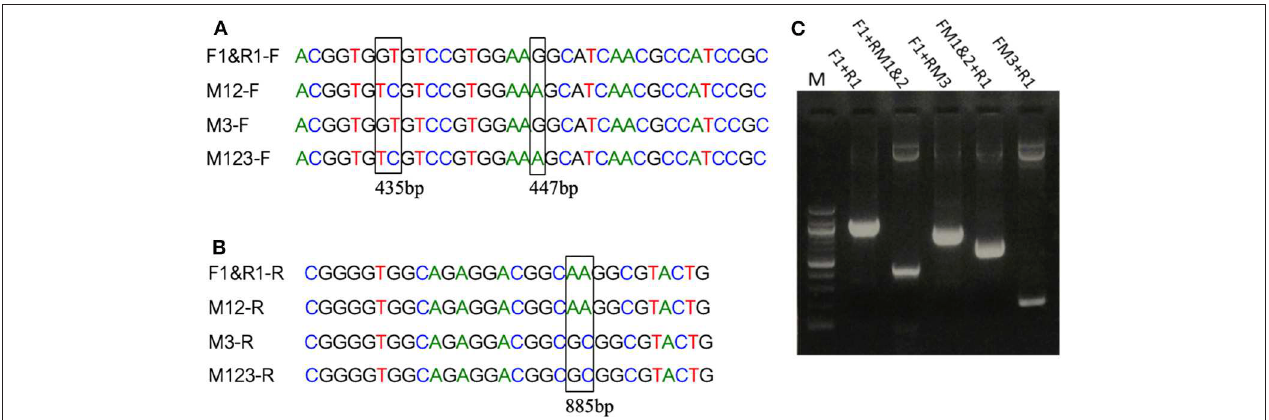
FIGURE 2 | Introduction of mutations in EP-B2 by error-prone PCR. (A,B) Results of DNA sequencing showing the location of the desired point mutations (marked by a rectangle in the sequence alignment). M1 = GT to TC transversions, M2 = G to A transition and M3 = A to G transition, M12 represents a combination of M1 and M2, and M123a combination of M1, M2, and M3. F1&R1 represents the wildtype sequence. F and R in the sequence names designate DNA sequences in Forward ( + ) and Reverse (–) orientations. (C) Agarose gel analysis of the PCR products obtained using various combination of primers (for primer sequences, see Table S1 ). Different sets of primers were used in PCR to obtain different combinations of mutations and thus various EP-B2 variants.